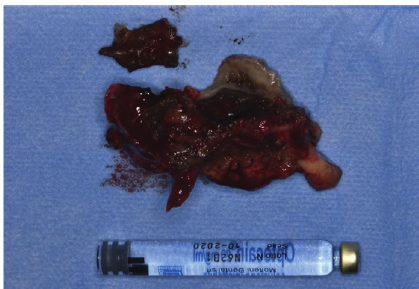
Figure 3: The wide bone sequestration of the right hemimaxilla obtained after